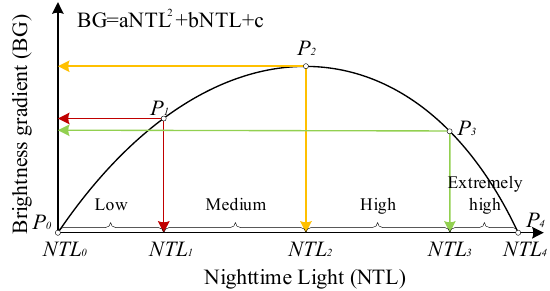
Figure 4. Partition diagram of the quadratic relationship between BG and NTL.